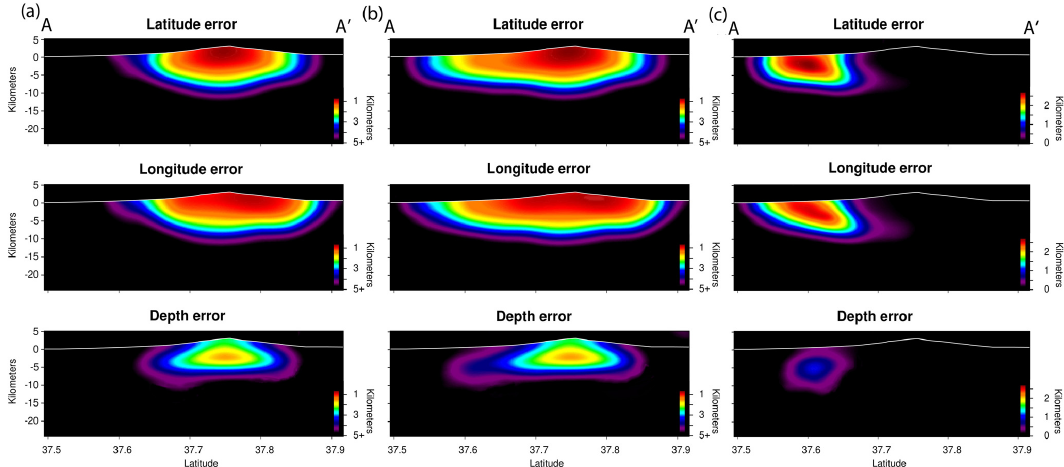
Fig. 8. Vertical section of hypocenter location uncertainty estimates between points A (37.495 ◦ N, 15.00 ◦ E) and A 0 (37.92 ◦ N, 15.00 ◦ E), for M L 1.5 and confidence level of 95% (see Fig. 3), respectively for (a) ESN, (b) ESN + CS and (c) (ESN +